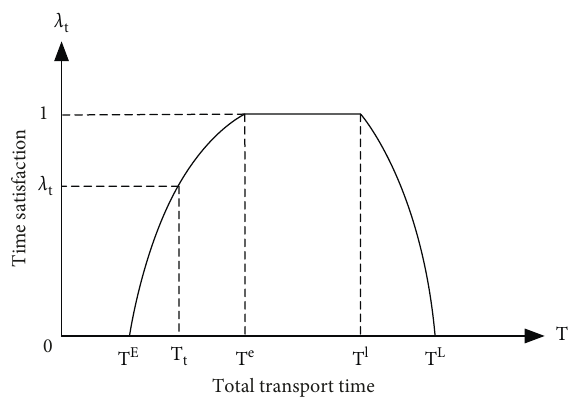
Figure 3: Time satisfaction